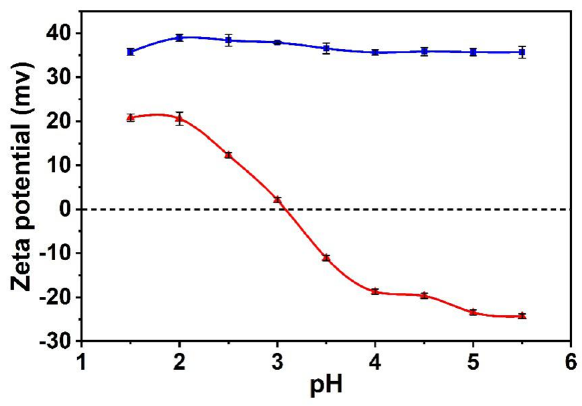
Figure 4. Zeta potential of Fe 3 O 4 @SiO 2 @UiO-66 (blue line) and Fe 3 O 4 @SiO 2 @UiO-66-TPP (red line) NPs.